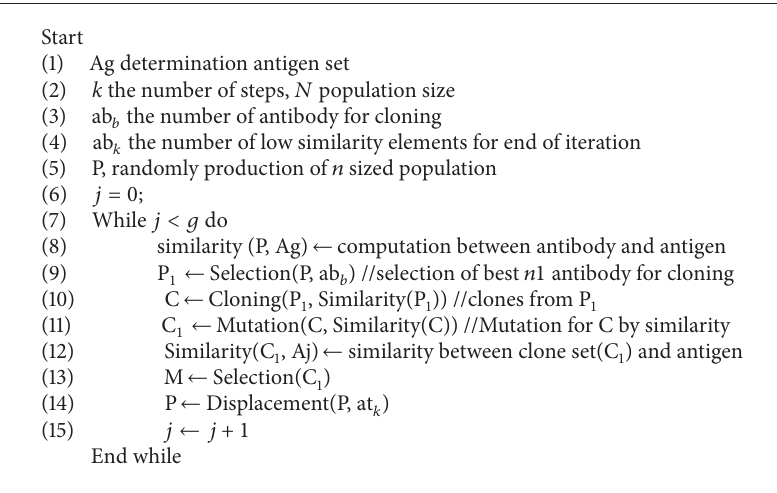
Pseudocode 1: The pseudocode of clonal selection algorithm.